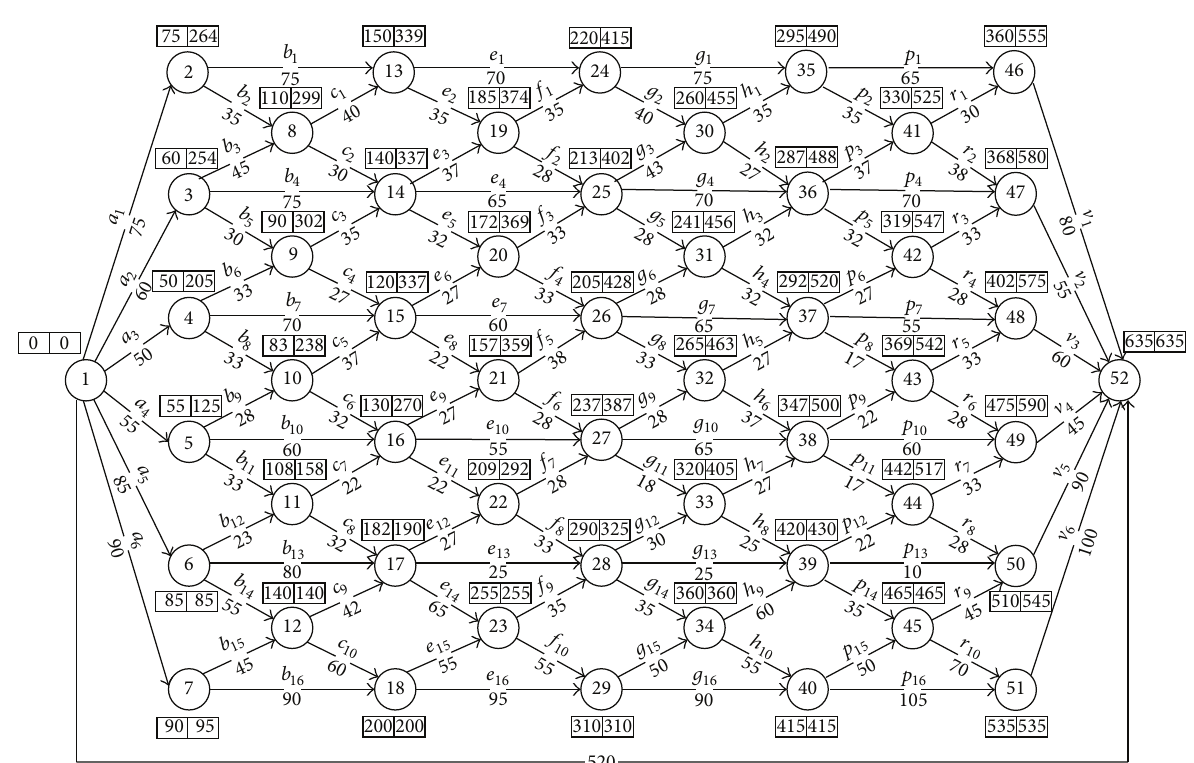
Figure 2: Time parameters for all activities with their remaining longest